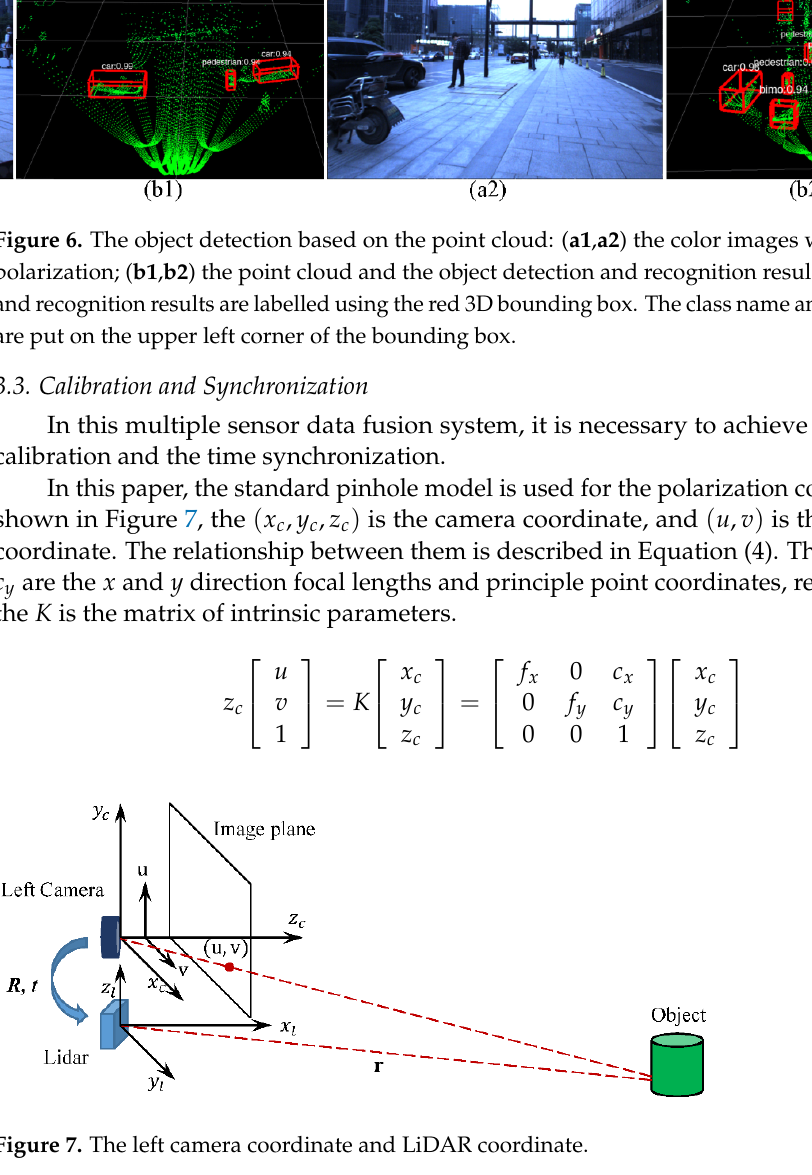
Figure 6. The object detection based on the point cloud: ( a1 , a2 ) the color images with zero-degree polarization; ( b1 , b2 ) the point cloud and the object detection and recognition results. The detection and recognition results are labelled using the red 3D bounding box. The class name and the confi- dence are put on the upper left corner of the bounding box.